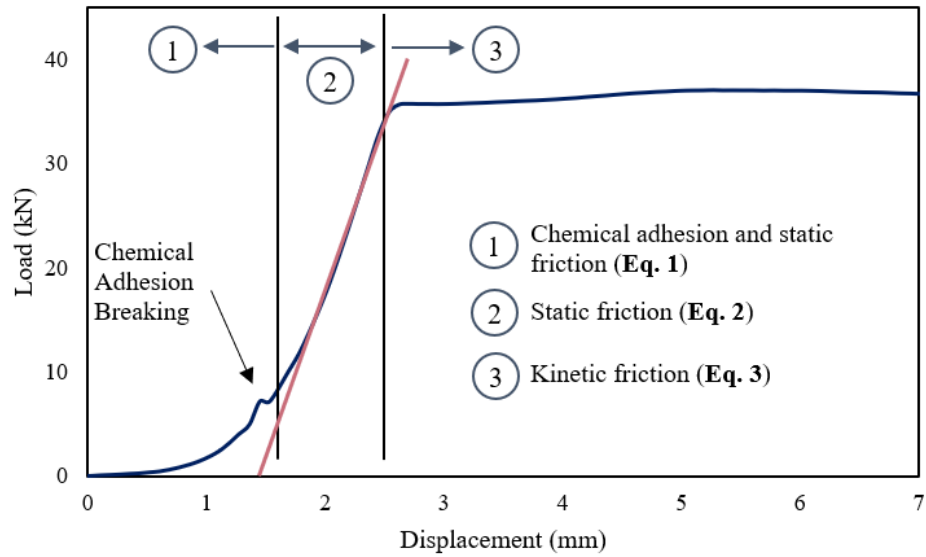
Figure 6. Validity regions of Equations (1)–(3) to obtain the bond strength between FRP tube and concrete [44].